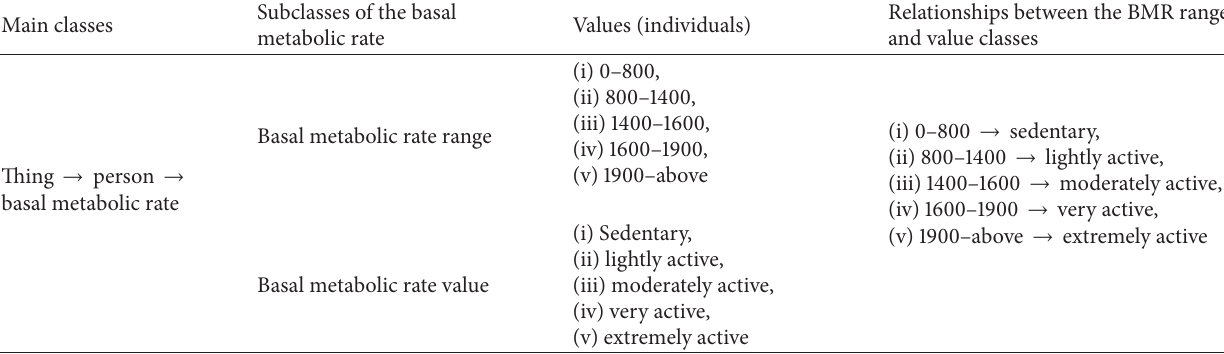
Table 3: Basal metabolic rate class includes two subclasses: basal metabolic rate range and basal metabolic rate value, with their values for individuals.